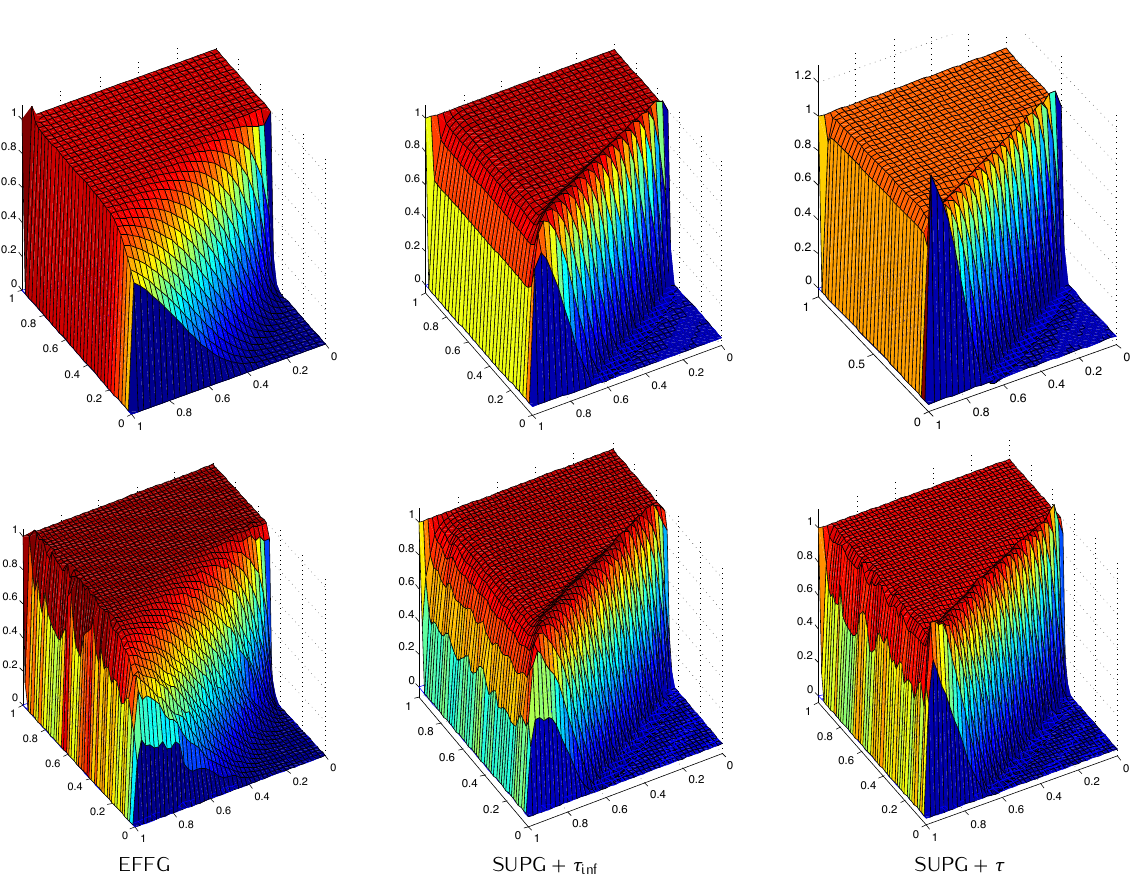
Figure 7. Solution of the skew advection test problem (30) with ε = 0 . 00001 by EFFG (left) vs. SUPG with τ inf (center) and SUPG with τ (right) on 33 × 33 grids. Top row: uniform grid. Bottom row: randomly perturbed